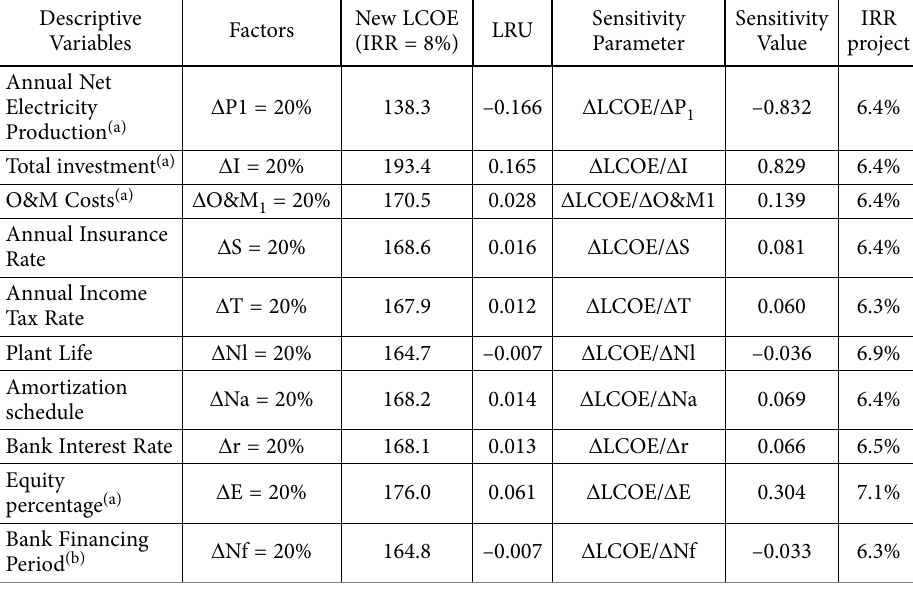
Table 4. Sensitivity analysis: results for the Spanish CSP plants Descriptive